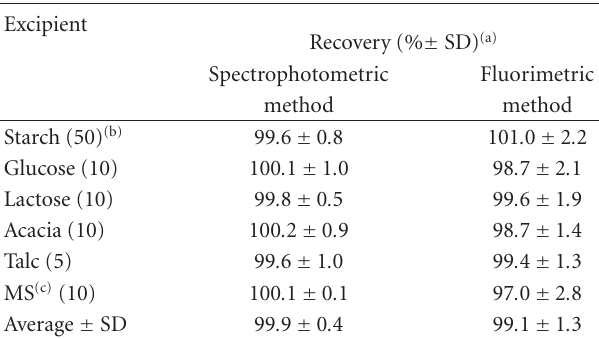
Table 5: Analysis of FLX in presence of common excipients by the proposed spectrophotometric and fluorimetric methods.